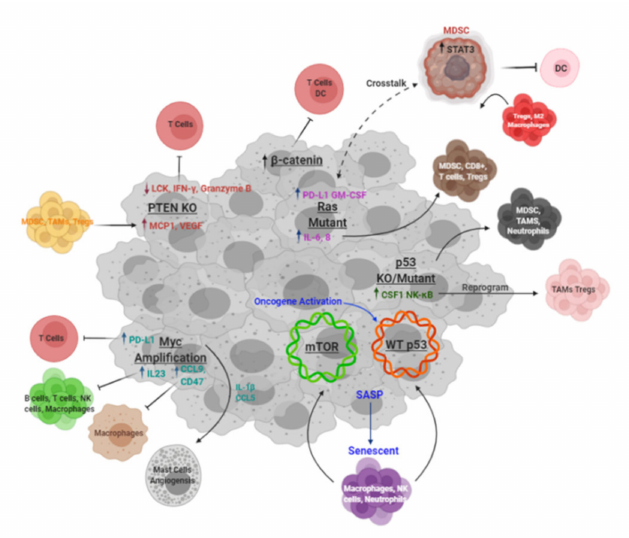
Figure 2. Tumor-driven mechanisms of immunosuppression. Schematic of known mechanisms of immunosuppression driven by key oncogenes and tumor suppressors. Created with BioRender.com (accessed on 6 April